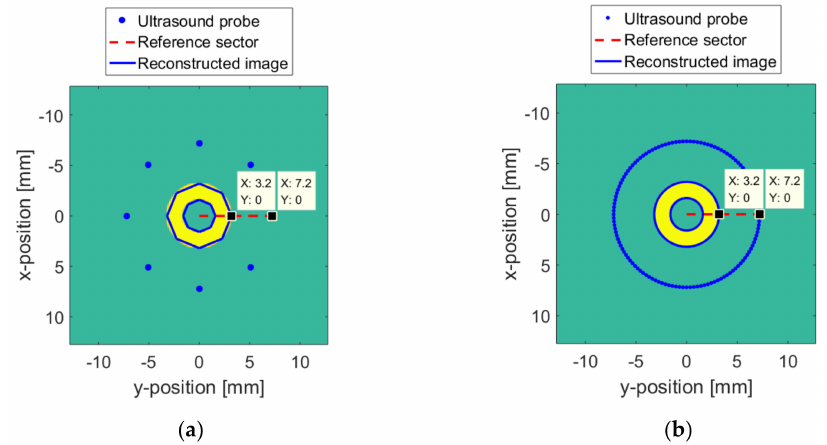
Figure 15. The numerical model: ( a ) ∆ v = 8; ( b ) ∆ v = 128.